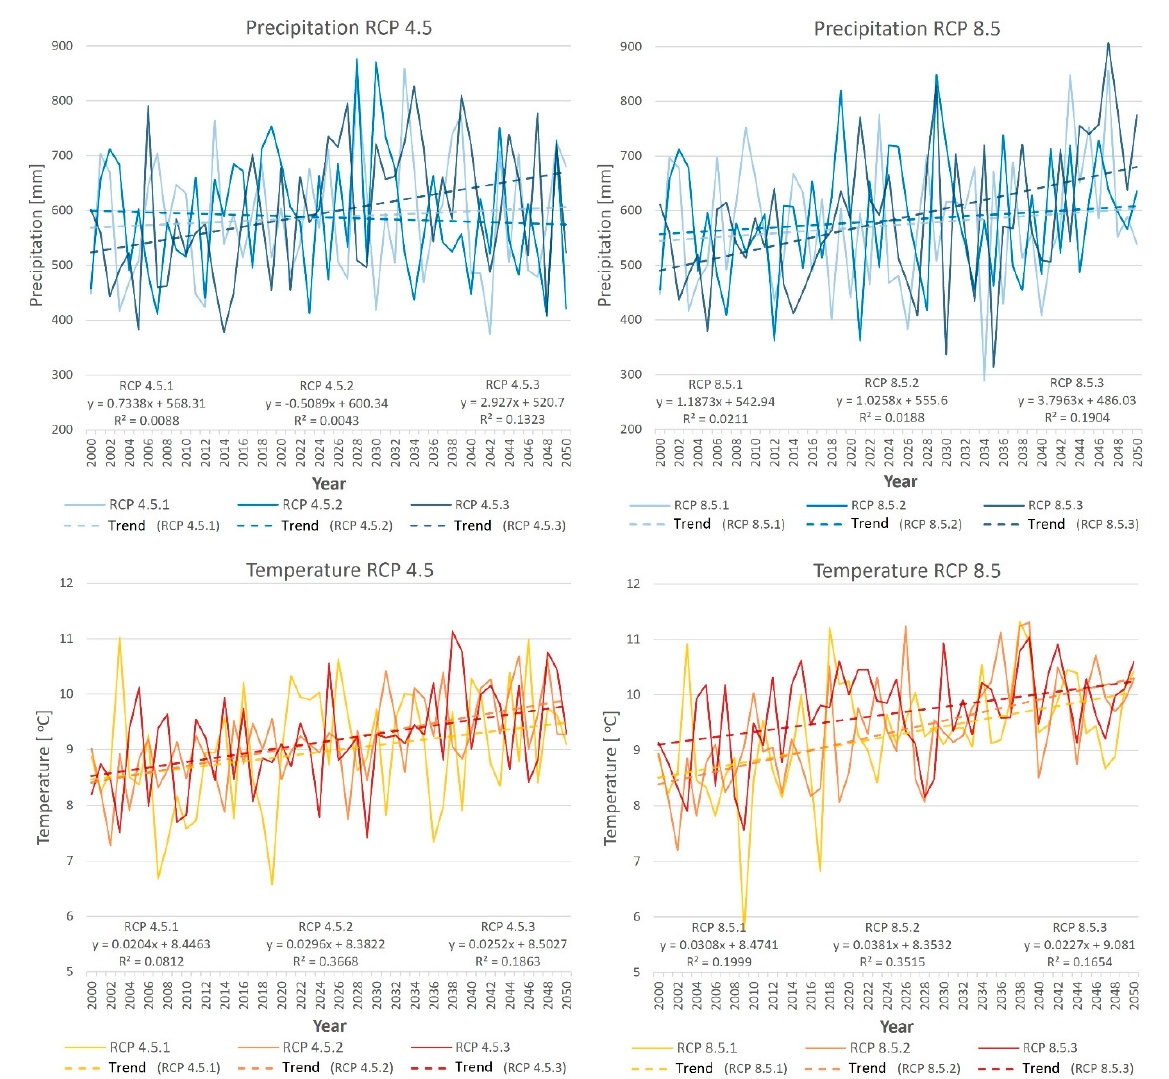
Figure 8. The average annual sum of precipitation and the average annual temperature in the Bystra River catchment area in the years 2000–2050 for individual climate projections in the RCP 4.5 and RCP 8.5 scenarios with trend lines (own study).